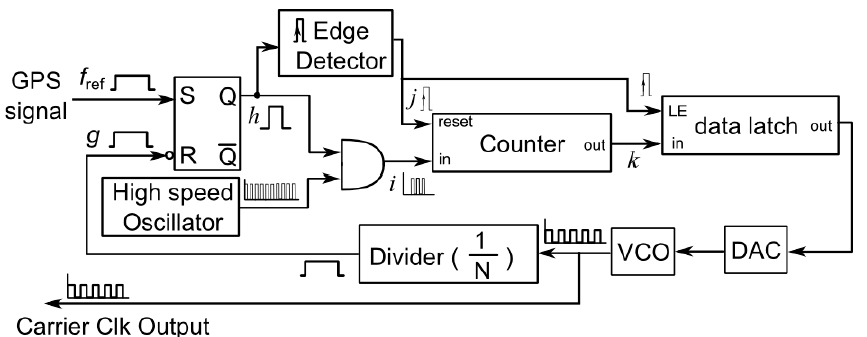
Figure 3. Frequency multiplier using DPLL.